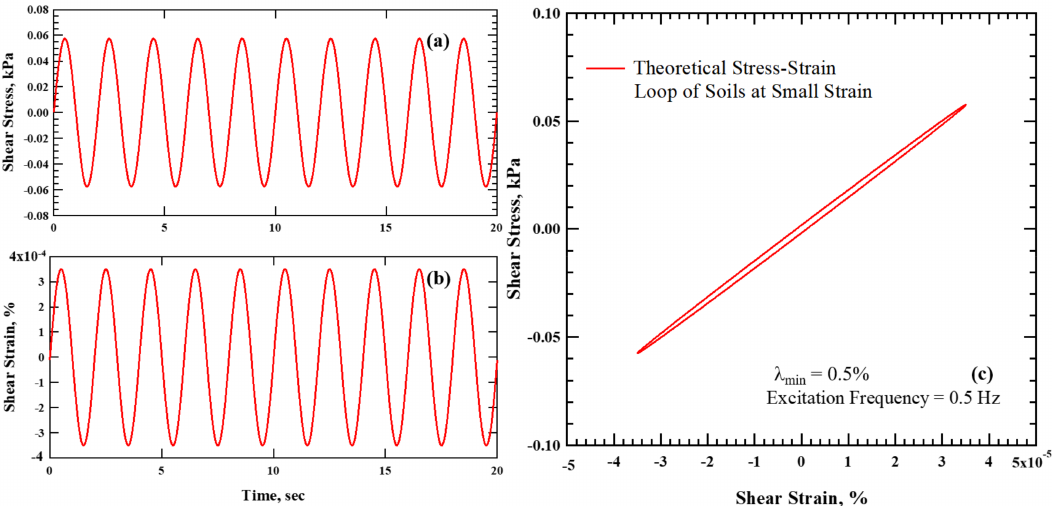
Figure 2. ( a ) Time series of an ideal stress signal, ( b ) time series of an ideal strain signal, and ( c ) theoretical stress–strain loop of soil with λ min of